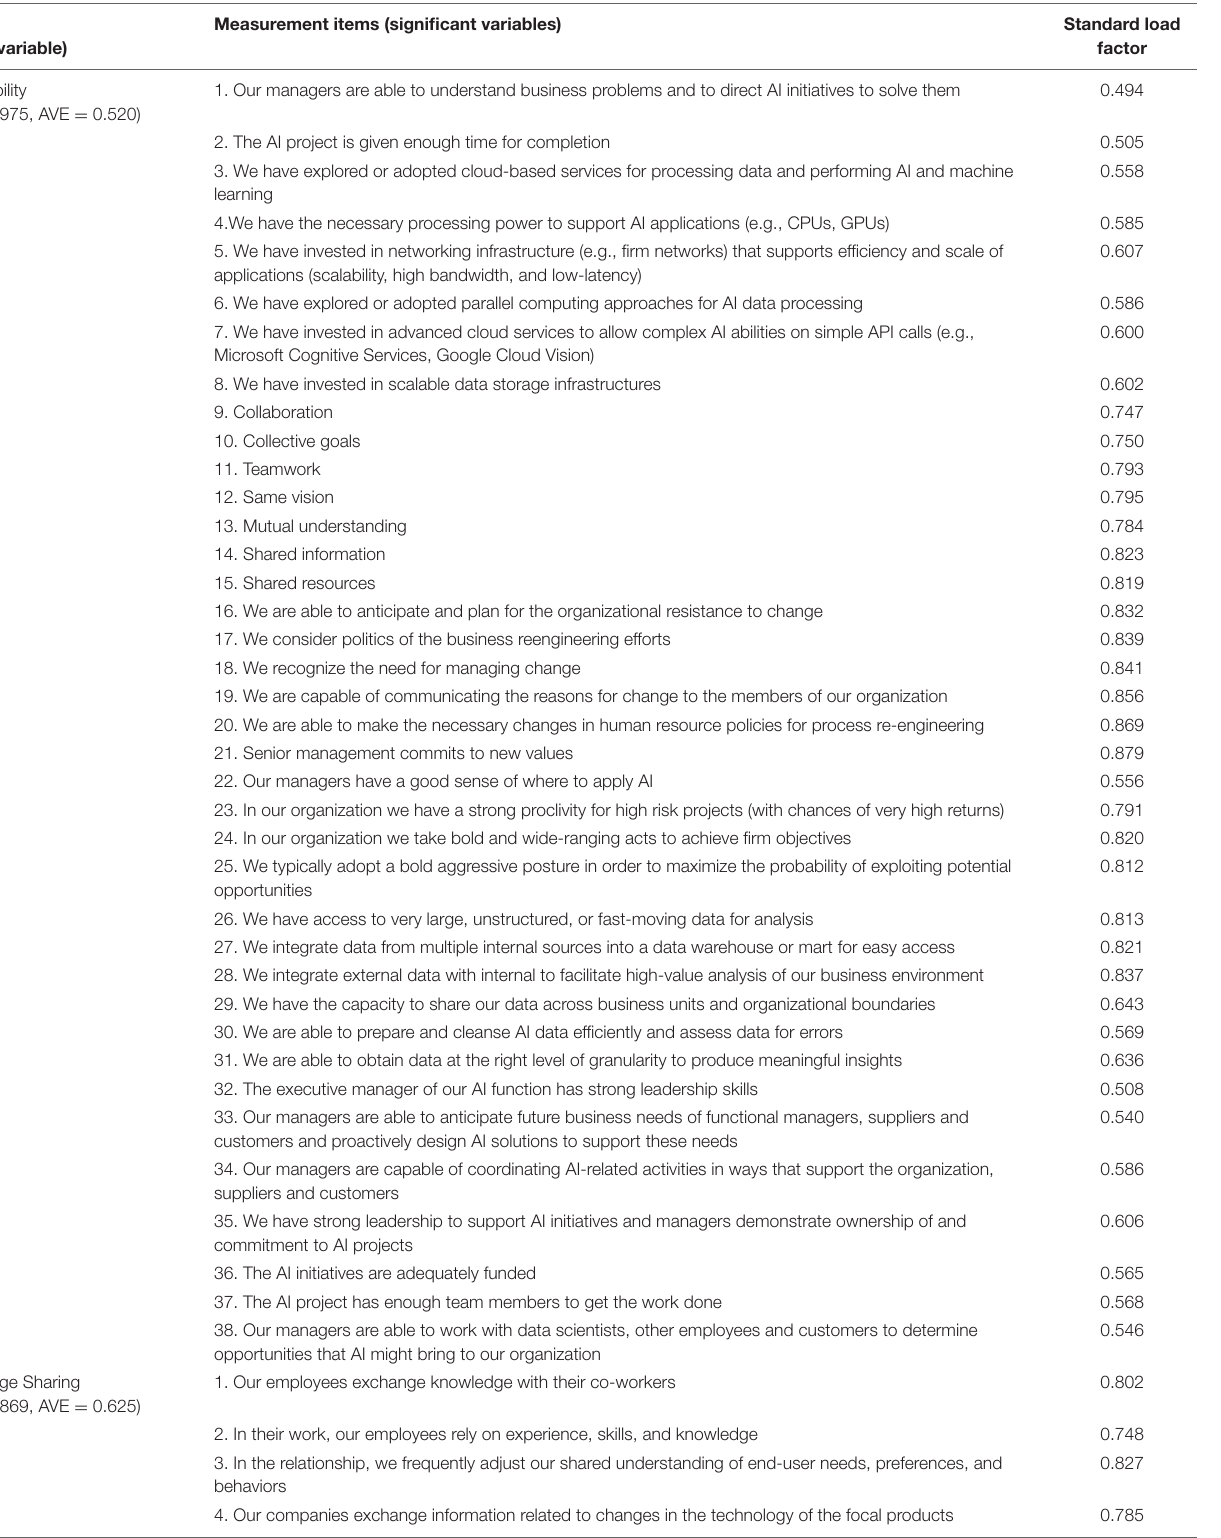
TABLE 4 | Scale items and validity tests. Factor Measurement items (significant variables) Standard load (Latent variable)